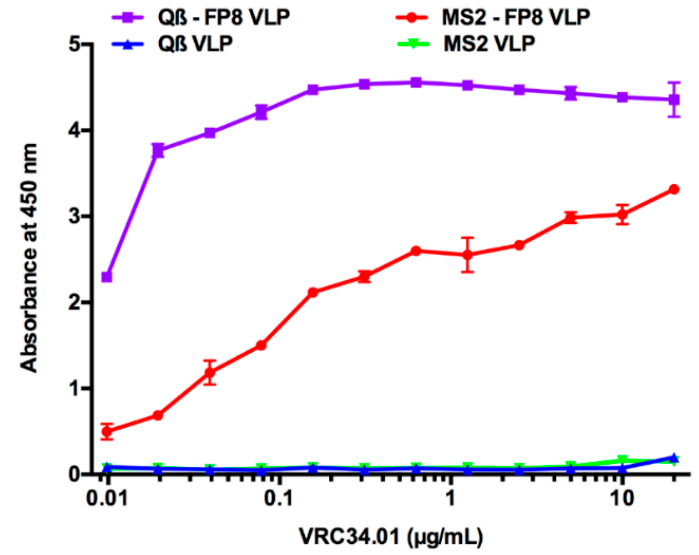
Figure 3. The FP8 peptide epitope is displayed on Q β -VLPs and MS2-VLPs, as shown by ELISA. Q β -FP8 VLP, MS2-FP8 VLP, or wild type (Q β and MS2) VLPs (negative controls) were plated and probed with 2-fold dilutions of VRC34.01 bnAb. Reactivity of VRC34.01 confirms display of FP8 peptides on the surface of both VLPs. Absorbance values at each dilution point show the mean ± S.D of replicate wells (n =